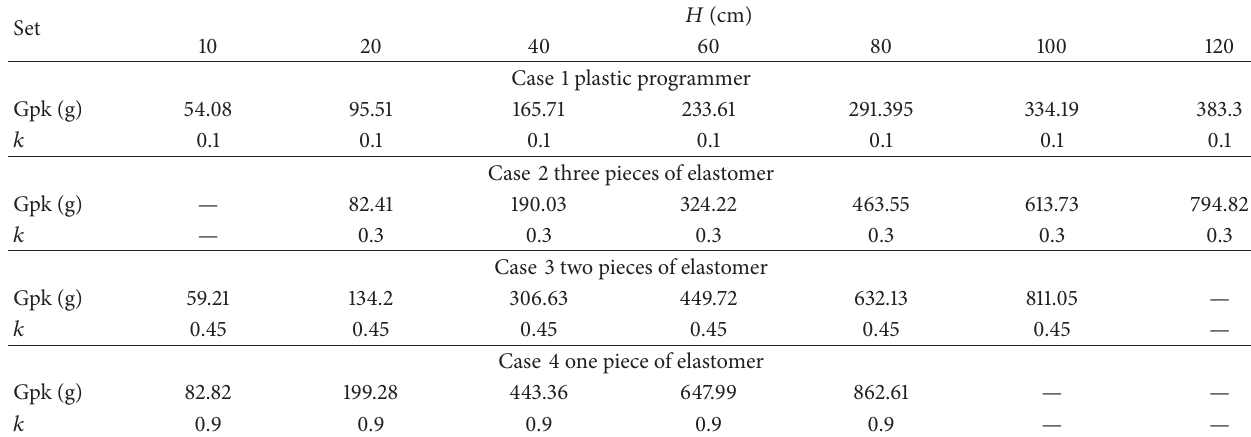
Table 1: Training data sets by free-fall shock machine.